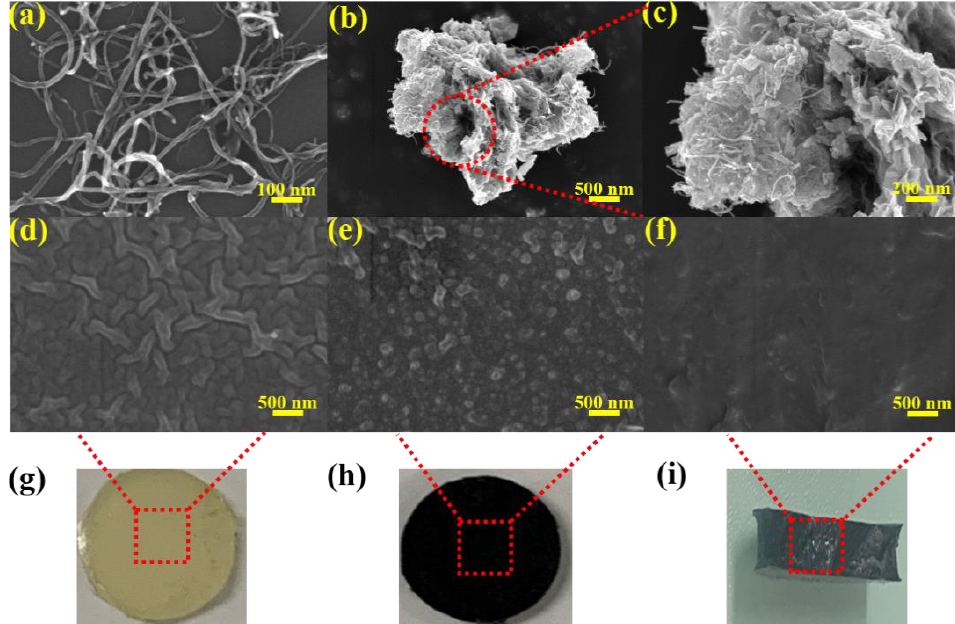
Figure 3. ( a ) SEM image of MWCNTs, ( b ) SEM image of WS 2 @MWCNTs, ( c ) SEM image correspond- ing to the selected area in ( b ), ( d , e ) SEM images of pure PUE and A-WS 2 @MWCNTs/PUE surface corresponding to the selected area in ( g , h ), and ( f ) SEM image of A-WS 2 @MWCNTs/PUE fracture corresponding to the selected area in ( i ).